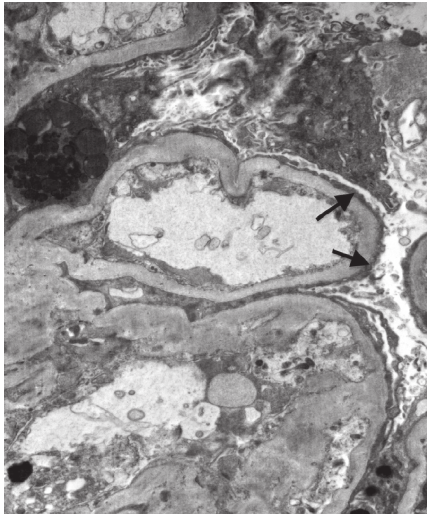
Figure 5: Electron microscopy showing diffuse foot process ef- facement